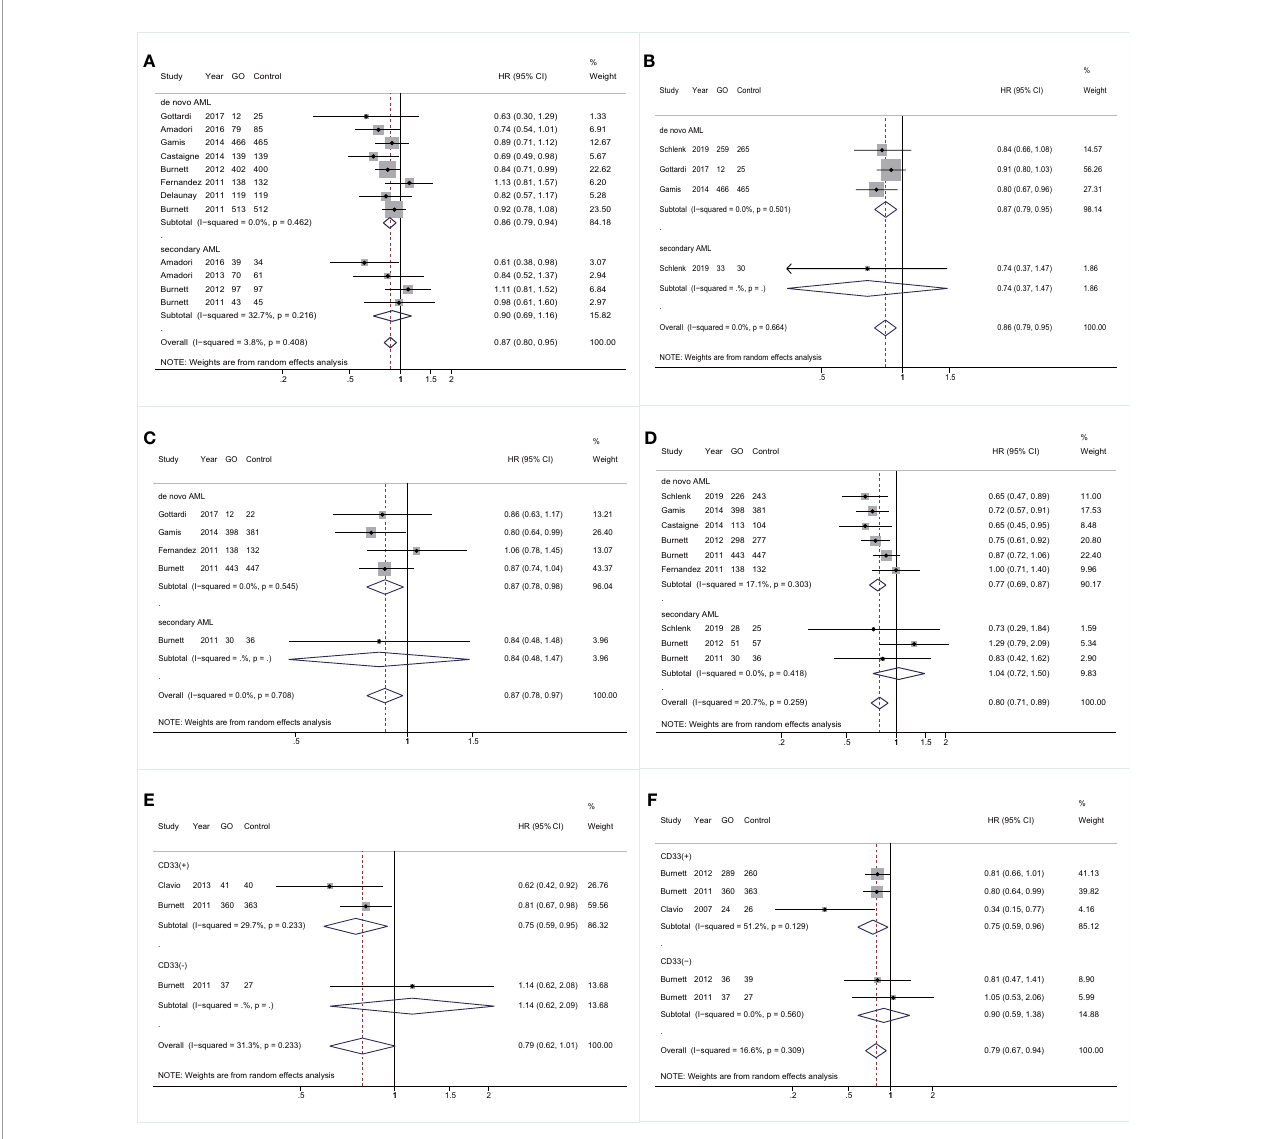
FIGURE 5 | Prognostic subgroup analyses regarding AML types and CD33 expression status. (A) OS subgrouped by AML types. (B) EFS subgrouped by AML types. (C) RFS subgrouped by AML types. (D) CIR subgrouped by AML types. (E) RFS subgrouped by CD33 expression status. (F) CIR subgrouped by CD33 expression status. The diamonds represent the overall summary HR estimates with 95% CI. GO, gemtuzumab ozogamicin; AML, acute myeloid leukemia; OS, overall survival; EFS, event-free survival; RFS, relapse-free survival; CIR, cumulative incidence of relapse; HR, hazard ratio; 95% CI, 95% con fi dence